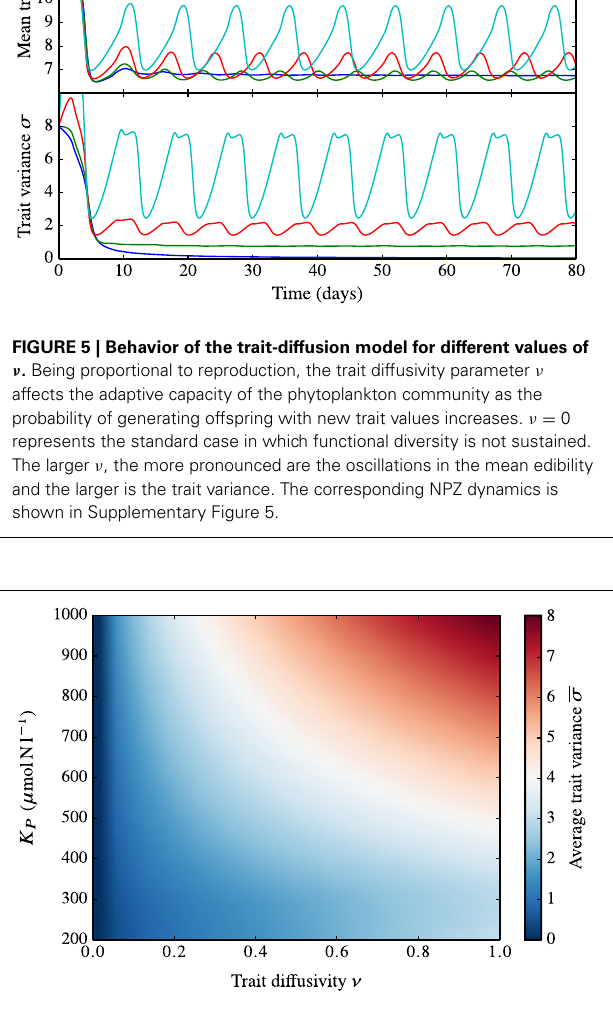
FIGURE 6 | Dependence of the average, steady-state trait variance on K P and ν . In the standard case ( ν = 0), K P has no impact on the trait variance (i.e., the average trait variance at steady-state is zero for all K P values). At increasing ν corresponds an increase in the adaptive capacity, which is amplified at higher K P